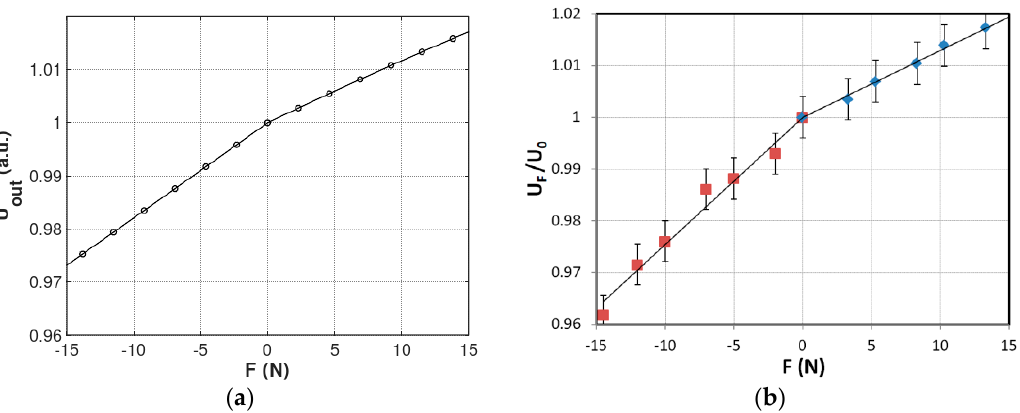
Figure 5. ( a ) The output voltage U out dependence on applied force F for the modeled magnetoelastic sensor in Mohri’s configuration, ( b ) the experimental results of the output voltage U F /U 0 dependence on applied force F. (red points - compressive force, blue points - tensile